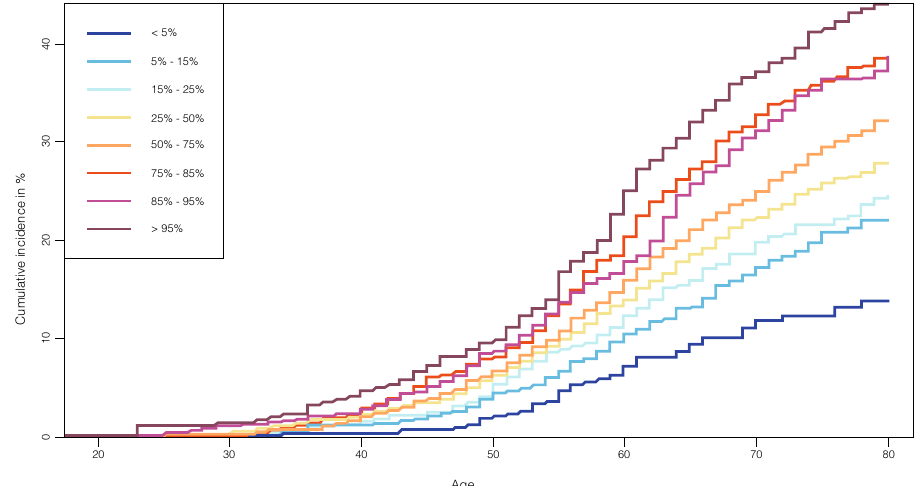
Fig. 4 Cumulative incidence by PRS categories. Cumulative incidence of POP in % scaled by age in the validation set of Estonian Biobank (2517 incident cases and 96,109 controls) for different POP PRS percentiles (<5%, 5 – 15%, 15 – 25%, 25 – 50%, 50 – 75%, 75 – 85%, 85 – 95%, >95%). Survival modeling and Cox proportional hazard models were implemented, using age as a time scale for properly accounting for left-truncation and right-censoring in the